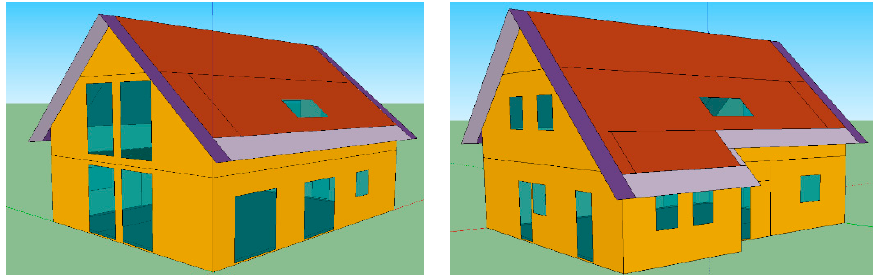
Figure 2. The building envelope as modelled in SketchUp: East-North orientation in left and West-South view in the right.